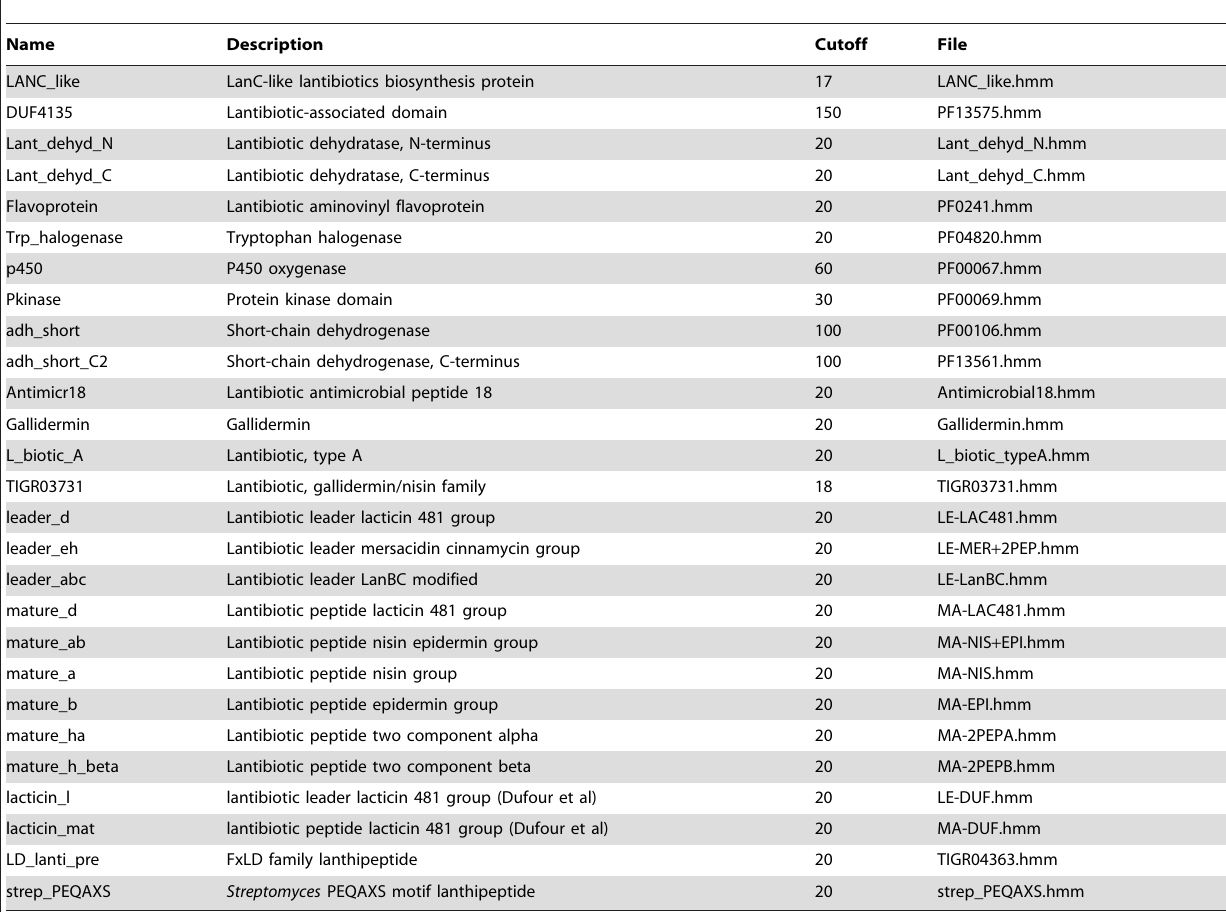
Table 1. Lanthipeptide-related HMM profiles and